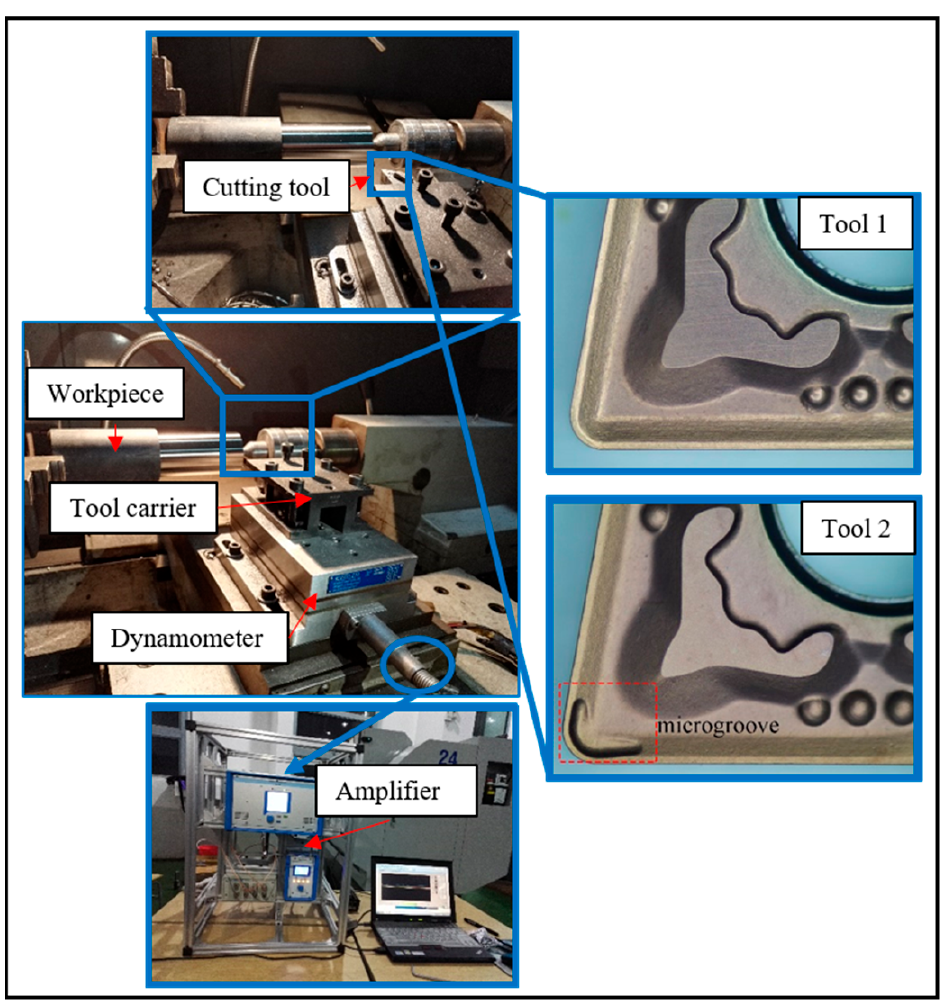
Figure 1. Experimental setup of turning superalloy Inconel 718 and cutting tools. Cutting experiments were performed on a C2-6136HK CNC lathe with coolant, as shown in Figure 1. The detailed input process parameters and responses that were used in the study are listed in Table 1. The recommended cutting parameters from the tool manufacturer were a cutting speed of v c = 35 m/min, depth of cut a p = 1.5 mm, and feed rate f = 0.1 mm/ rev . The workpiece was Inconel 718 cylindrical bar through solid solution and aging heat treatment process, with the chemical composition and physical parameters as shown in Tables 1 and 2,